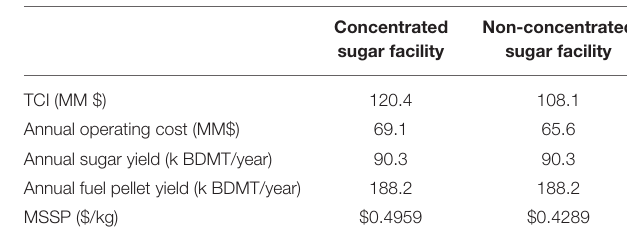
TABLE 4 | TCI, annual operating costs and MSSP for concentrated and non-concentrated